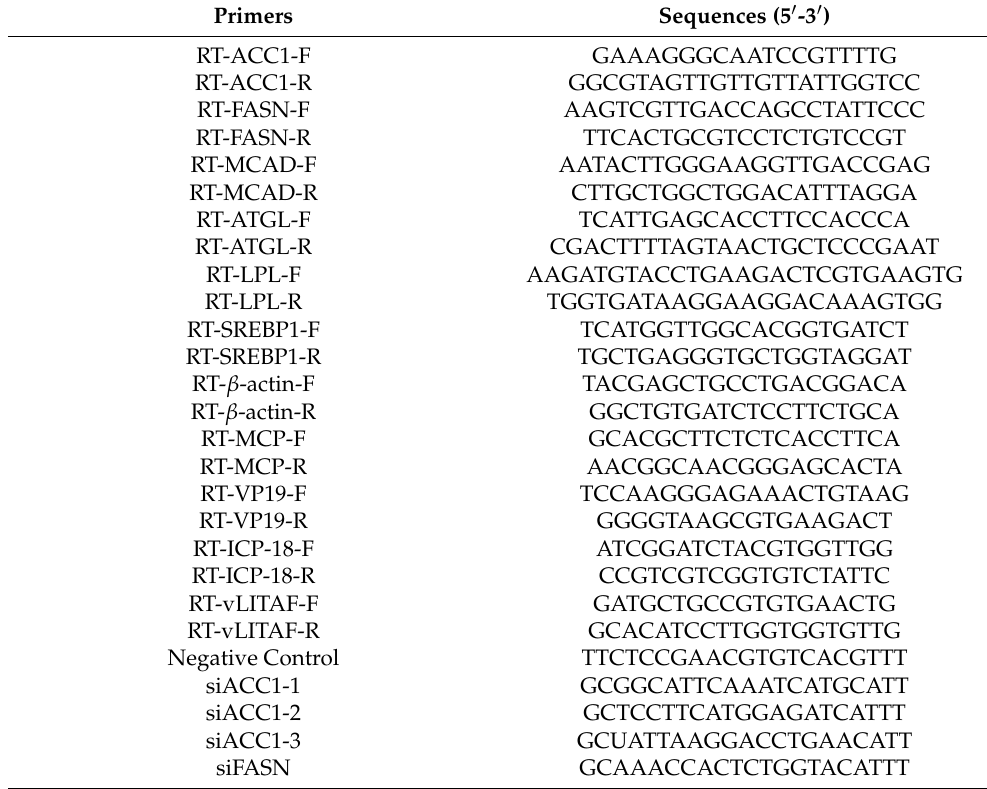
Table 1. Sequences of primers used in this study.